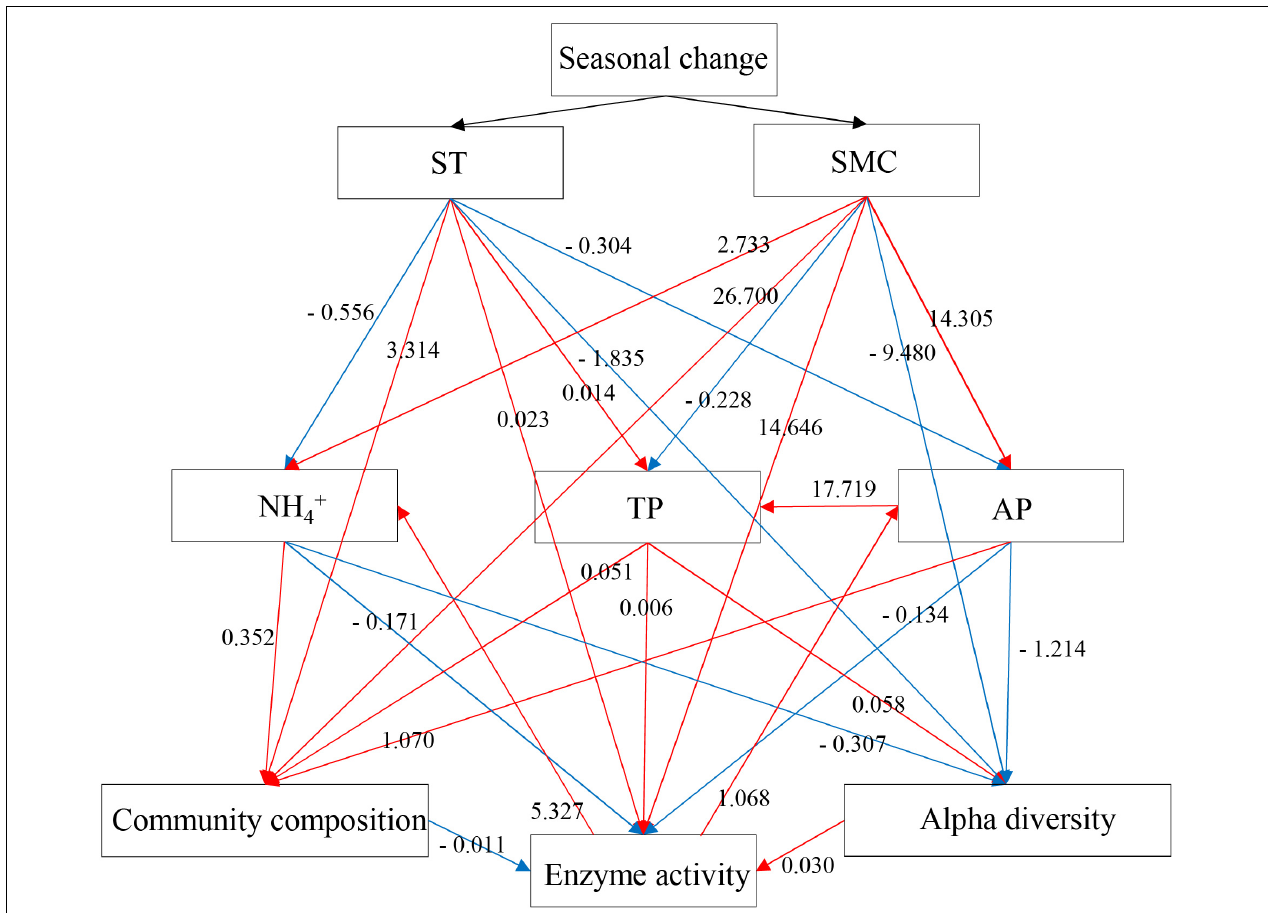
FIGURE 7 | Structural equation model (SEM) showing the causal relationships among the soil bacterial community composition, alpha-diversities, enzymatic activities and edaphic properties (ST, SMC, TP, AP, and NH 4 + ) in P . tabulaeformis forest based on the results of Mantel statistics. The final model fits the data well: maximum likelihood, χ 2 = 0.1, df = 2, P = 0.948, goodness-of-fit index = 0.998, Akaike information criteria = 68.106 and root mean square error of approximation = 0. Red lines mean the positive standardized regression weights and blue lines indicate the negative standard regression